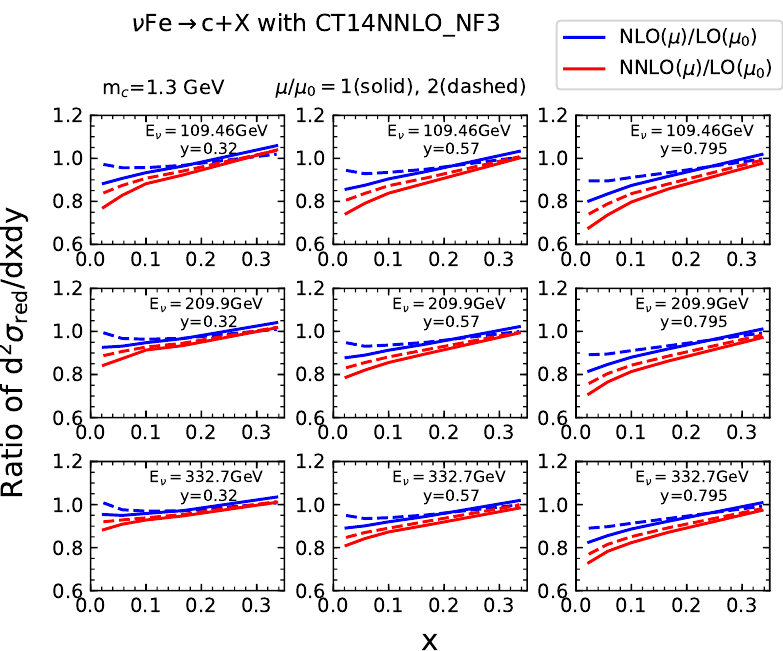
Figure 4 . QCD predictions at di(cid:11)erent orders with scale choices of (cid:22) 0 and 2 (cid:22) 0 for a double di(cid:11)erential reduced cross section in Bjorken x and inelasticity y for charm quark production from neutrino scattering on iron target.